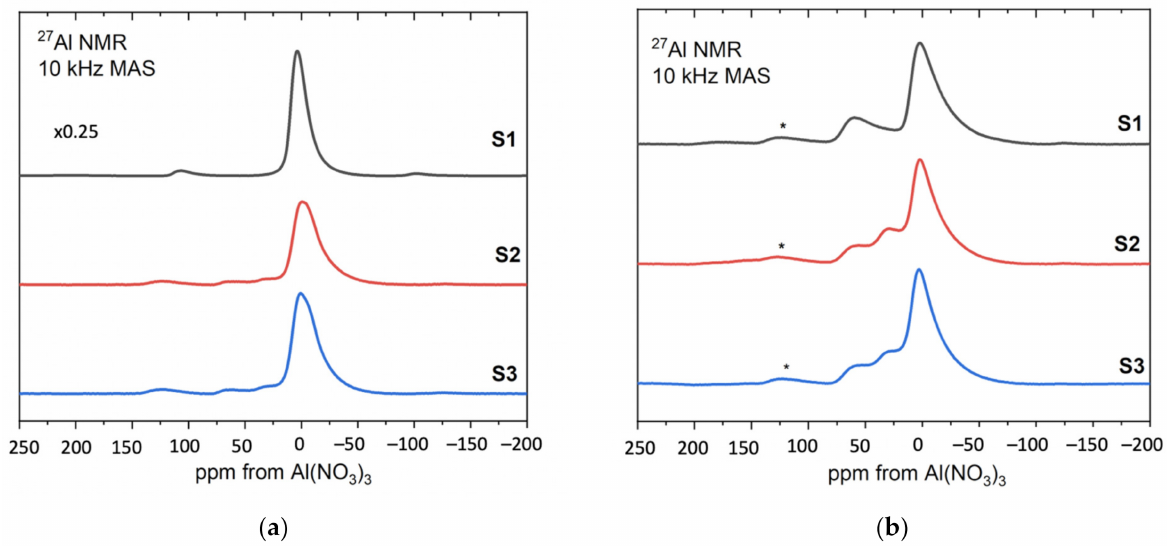
Figure 10. The 27 Al MAS NMR spectra of the samples S1, S2, S3—( a ) before and ( b ) after heat